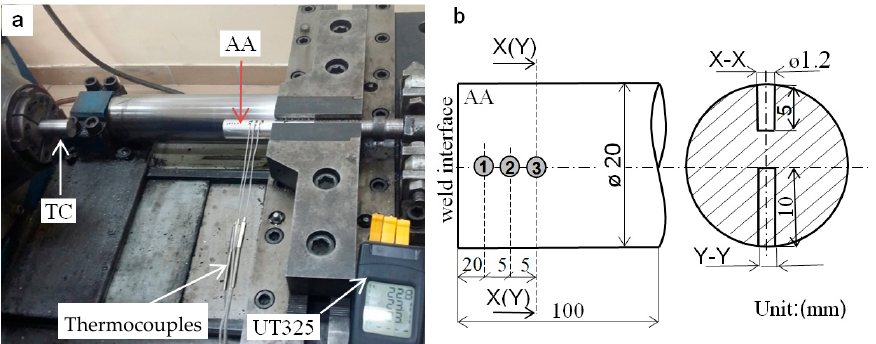
Figure 3. ( a ) Experimental setup of thermocouples in the nonrotating aluminum sample, and ( b ) a schematic representation of the arrangement.